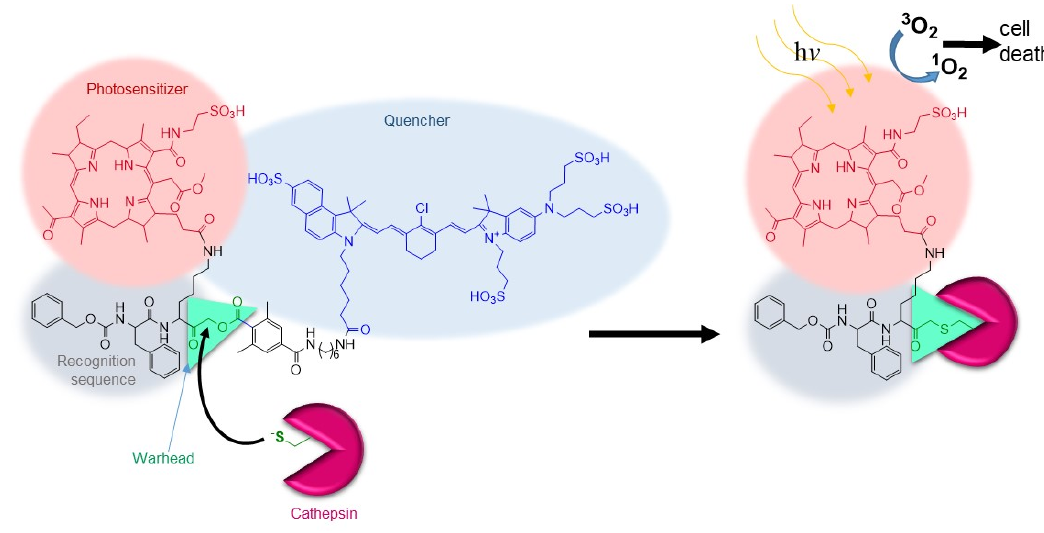
Figure 10. Chemical structure of YBN14 and labeling